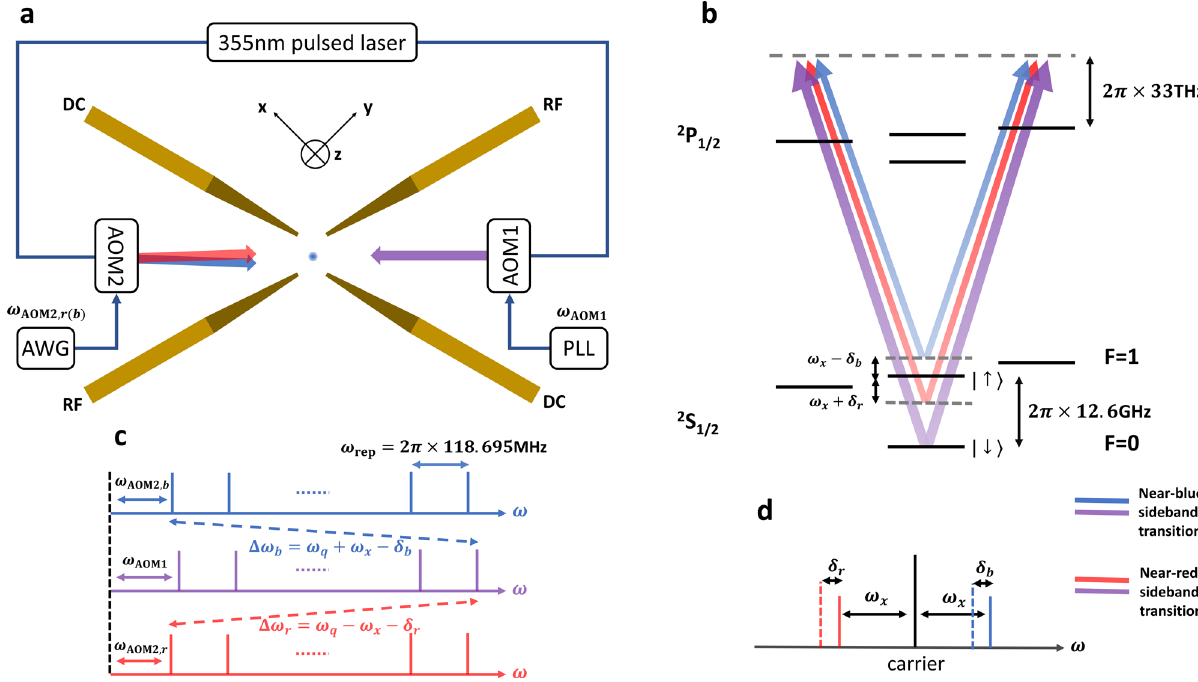
Fig. 1 Schematic for experimental observation of QPT in the quantum Rabi model. a Schematic experimental setup. The 171 Yb + ion is con fi ned in the middle of a four-blade Paul trap, with the principal axes of the secular motion along the x , y , and z directions. Two counter-propagating 355 nm pulsed-laser beams are focused on the ion, with a nonzero differential wave vector component along the x direction. The two laser beams are controlled by two acousto- optic modulators (AOMs). AOM1 is driven by a radio-frequency (RF) signal from a phase-locked loop (PLL) 56 and AOM2 is controlled by an arbitrary waveform generator (AWG). b Schematic level structure of 171 Yb + . The two qubit states are two 2 S 1/2 hyper fi ne ground states " (cid:5) (cid:5) (cid:6) (cid:6) (cid:5) (cid:5) # ¼ F ¼ 0 ; m ¼ 0 , at the separation ω q ≈ 2 π × 12.6 GHz. The Raman transition is mediated by a virtual level about 2 π × 33 THz above the 2 P 1/2 levels. F The differential frequencies of the laser beams are tuned close to the blue and the red motional sidebands, i.e., ω x − δ b and − ( ω x + δ r ) from the carrier transition. The legend at lower right shows clearly that the purple beam and the blue (red) beam form a near-blue-sideband (near-red-sideband) Raman transition. c The 355 nm pulsed laser has a frequency-comb structure 42 with the repetition rate ω rep ≈ 2 π × 118.695MHz. With small frequency adjustments in the AOMs, the desired Raman transitions can be achieved between distant teeth of the frequency combs. d Relative positions of the carrier transition (black) and two motional sidebands (red and blue) in solid lines and the bichromatic Raman-transition frequencies (red and blue) in dashed